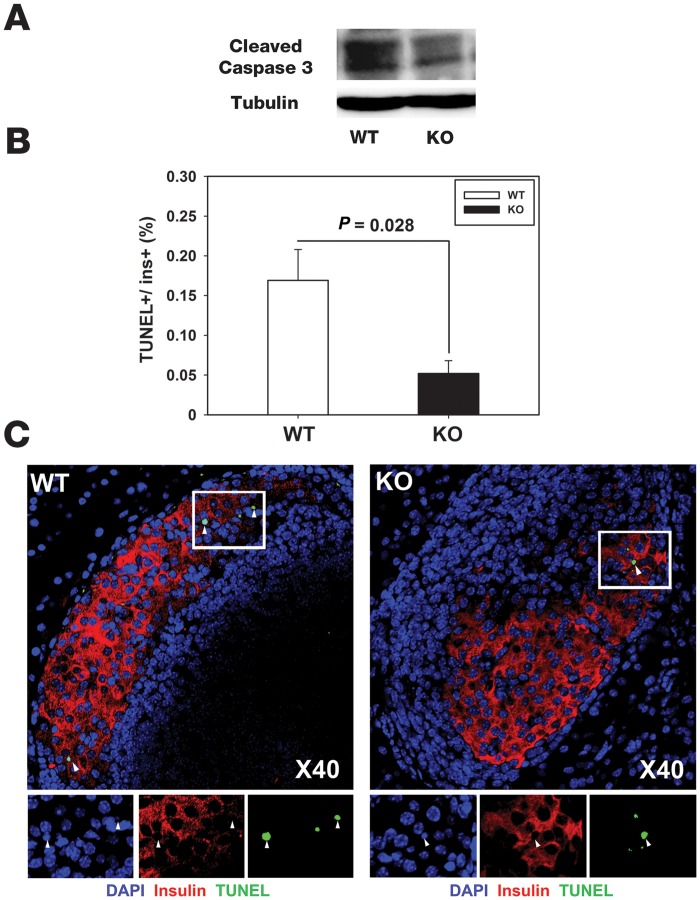
Insulin-producing β cells from WT NOD females display enhanced susceptibility to apoptosis.A) Enhanced caspase-3 activity is detected in cell extracts of WT than in those of CD44-deficient pancreatic islet cells. Pancreatic islet cells were freshly removed from WT and CD44-deficient pre-diabetic NOD females. Cell extracts from islets were subjected to Western blot analysis, using anti-cleaved caspase-3 antibody. A representative Fig of three experiments. (B and C) Pancreata were harvested from 10-weeks-old normoglycemic WT and CD44-deficient NOD females (n = 5 in each group). β-cell apoptosis was assessed using TUNEL assay (green) and co-staining for insulin (red) and DNA (blue). B) Apoptosis was calculated as percent of TUNEL positive nuclei (+/- SEM) in insulin-positive cells out of the total number of insulin-positive cells per mouse. WT (white bar, ~17,560 total β-cells); CD44-deficient (black bar, ~14,800 total β-cells). C) Pictures are representative images of islets from WT (left panel) and CD44-deficient NOD females (right panel). Original images were taken at a magnification of x40. Inset images were digitally increased x5. White arrowheads point to apoptotic β-cells.